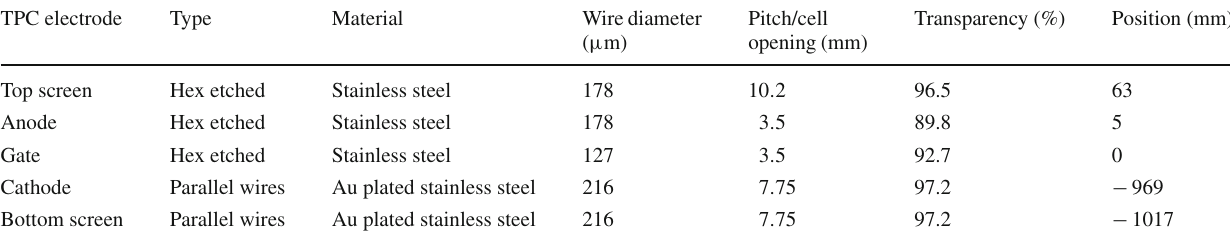
Table 1 Specifications of the five TPC electrodes. The bottom screen- ing electrode features a single wire installed perpendicularly mid-way to all others to minimize elastic deformation of the frame. The last col-